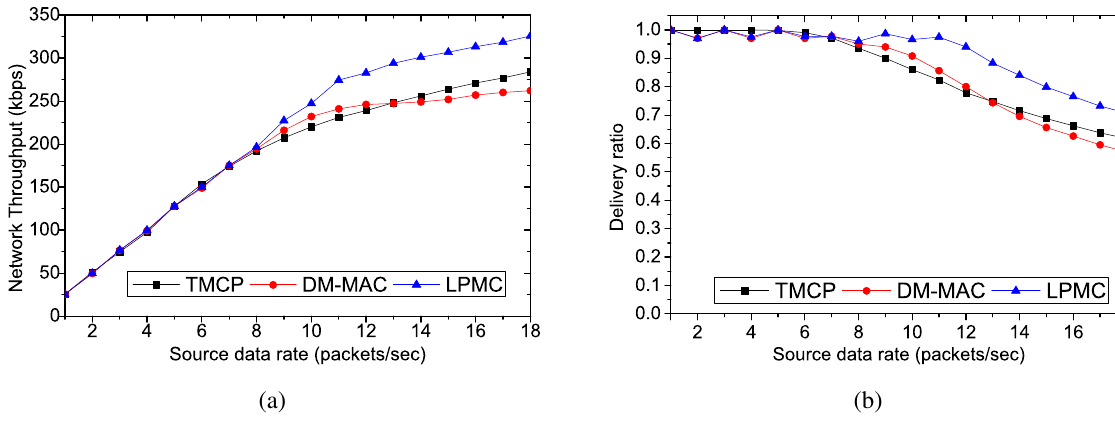
Figure 4. Performance comparison for randomly selected 50 sources with different data rates: (a) average end-to-end delay, (b) average channel capacity when all nodes achieve a fair